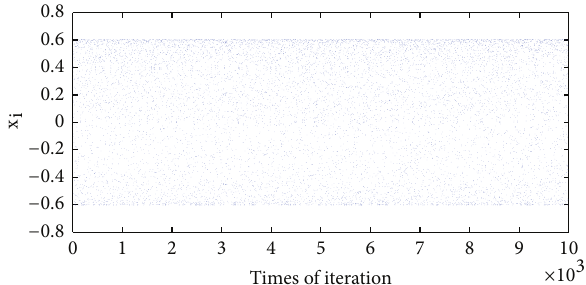
Figure 3: Scattered 10000 points gained from the new chaotic map.